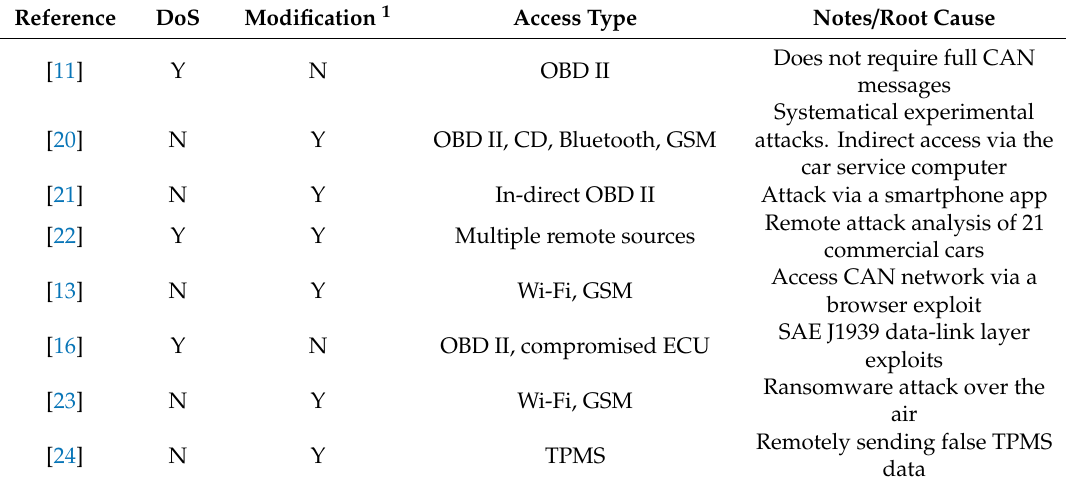
Table 1. Summary of the Controlled Area Network (CAN) bus